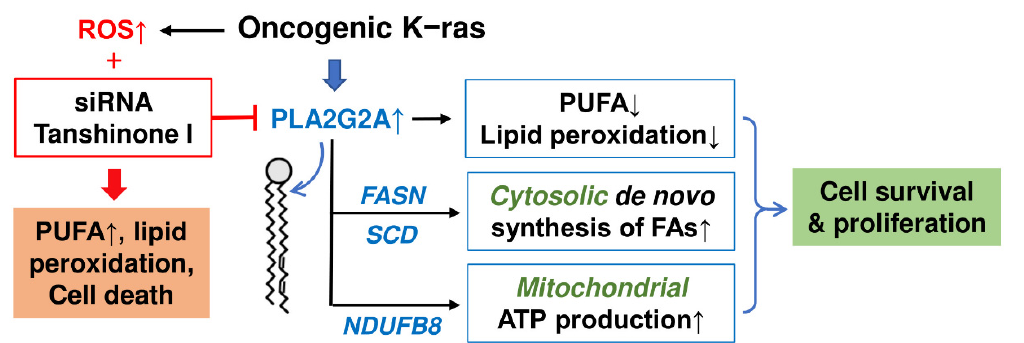
Figure 7. Schematic illustration of the mechanisms by which the upregulation of PLA2G2A by oncogenic K-ras promotes PDAC cell survival. Oncogenic K-ras is known to cause high ROS stress and render cancer cells more prone to ROS - induced lipid peroxidation and cell death. The elevated PLA2G2A induced by K-ras might be a novel mechanism to prevent lipid peroxidation through its ability to remove polyunsaturated fatty acids (PUFA) from lipid membranes. Since PUFA are highly vulnerable to ROS - mediated peroxidation, their removal from lipid membranes by PLA2G2A would prevent abnormal accumulation of PUFA and thus reduce the risk of lipid peroxidation and related damage. This also helps the maintenance of mitochondrial membrane integrity and metabolic functions. Furthermore, PLA2G2A upregulates the expression of FASN and other molecules involved in de novo fatty acid synthesis and promotes mitochondrial function and ATP generation.